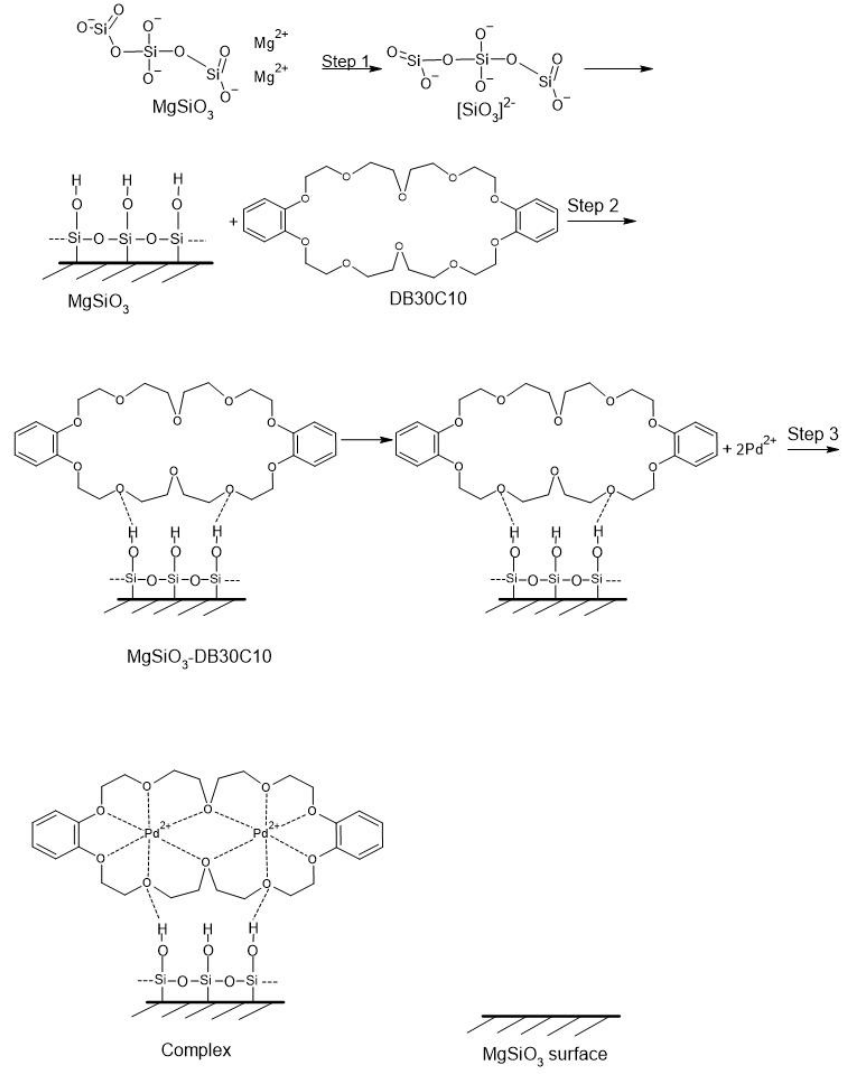
Figure 16. Mechanism for MgSiO 3 -DB30C10.